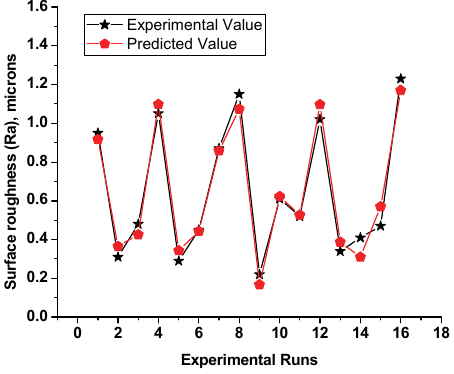
Fig. 5 . Experimental vs. predicted values of surface